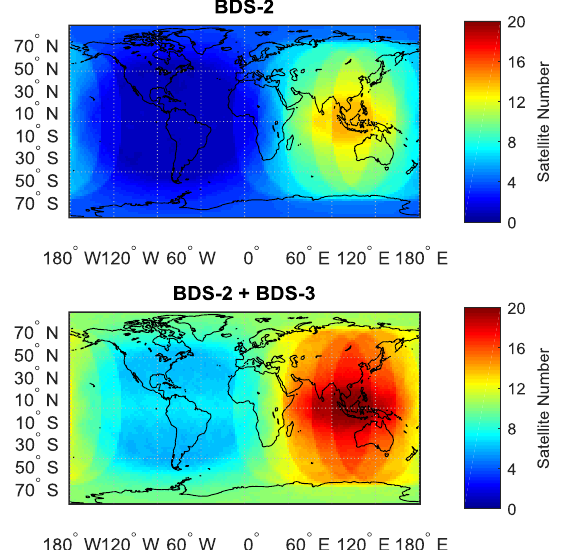
Figure 1. Average visible satellite number comparison of BDS-2 (upper) and BDS-2+BDS-3 (lower) for an elevation angle mask of 10°on 1 January 2019.